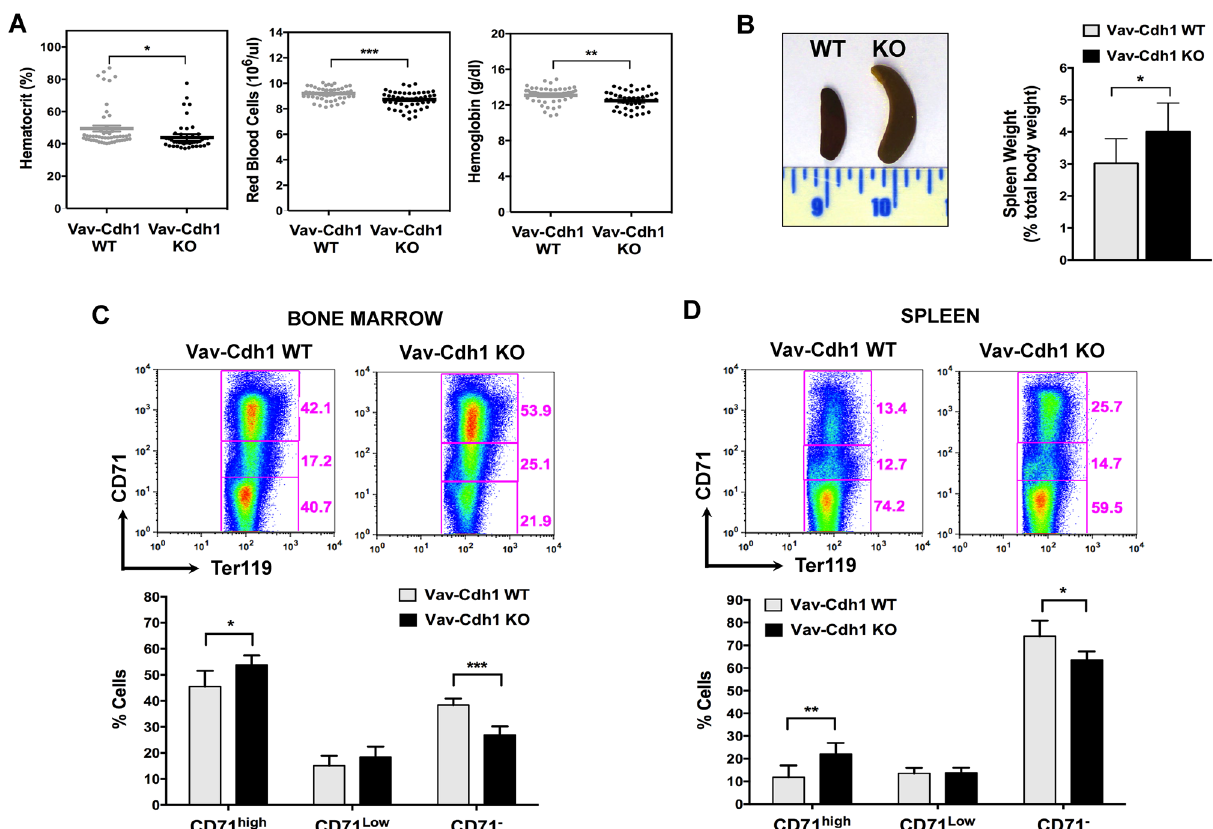
Figure 2. Signs of anemia and impaired terminal erythroid differentiation in adult mice lacking Cdh1 expression in hematopoietic cells. ( A ) Red cell parameters from peripheral blood of 8–12 week old mice of the indicated genotype. The scatter dot plots show mean ± s.e.m of the corresponding data. (n = 51 for Vav-Cdh1 WT and 46 for Vav-Cdh1 KO). ( B ) Relative weight of the spleen in control (Vav-Cdh1 WT) and mutant (Vav- Cdh1 KO) adult mice (n = 10). A representative picture is included (left). ( C , D ) Terminal erythroid maturation was assessed based on CD71 expression in Ter119 + gated cells in the bone marrow ( C ) and spleen ( D ) from adult mice of the indicated genotype. The relative abundance of populations showing high, low, or no CD71 expression, representing increasingly higher maturation stages, were quantified (bottom graphs). Representative flow cytometry plots are included (top panels). (n = 6). * P < 0.05, ** P < 0.01, *** P <